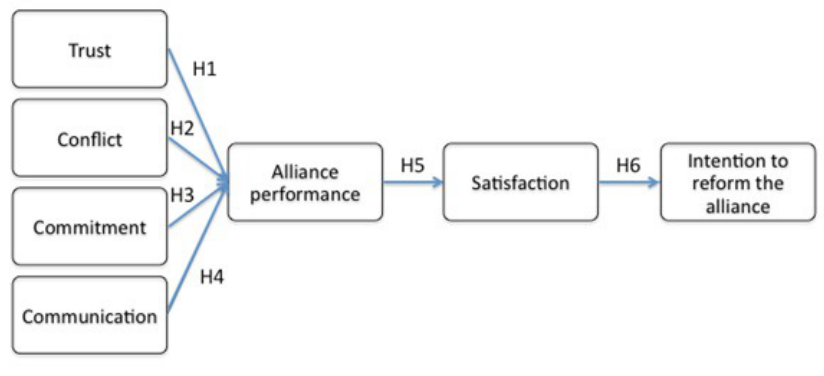
Figure 1. The research